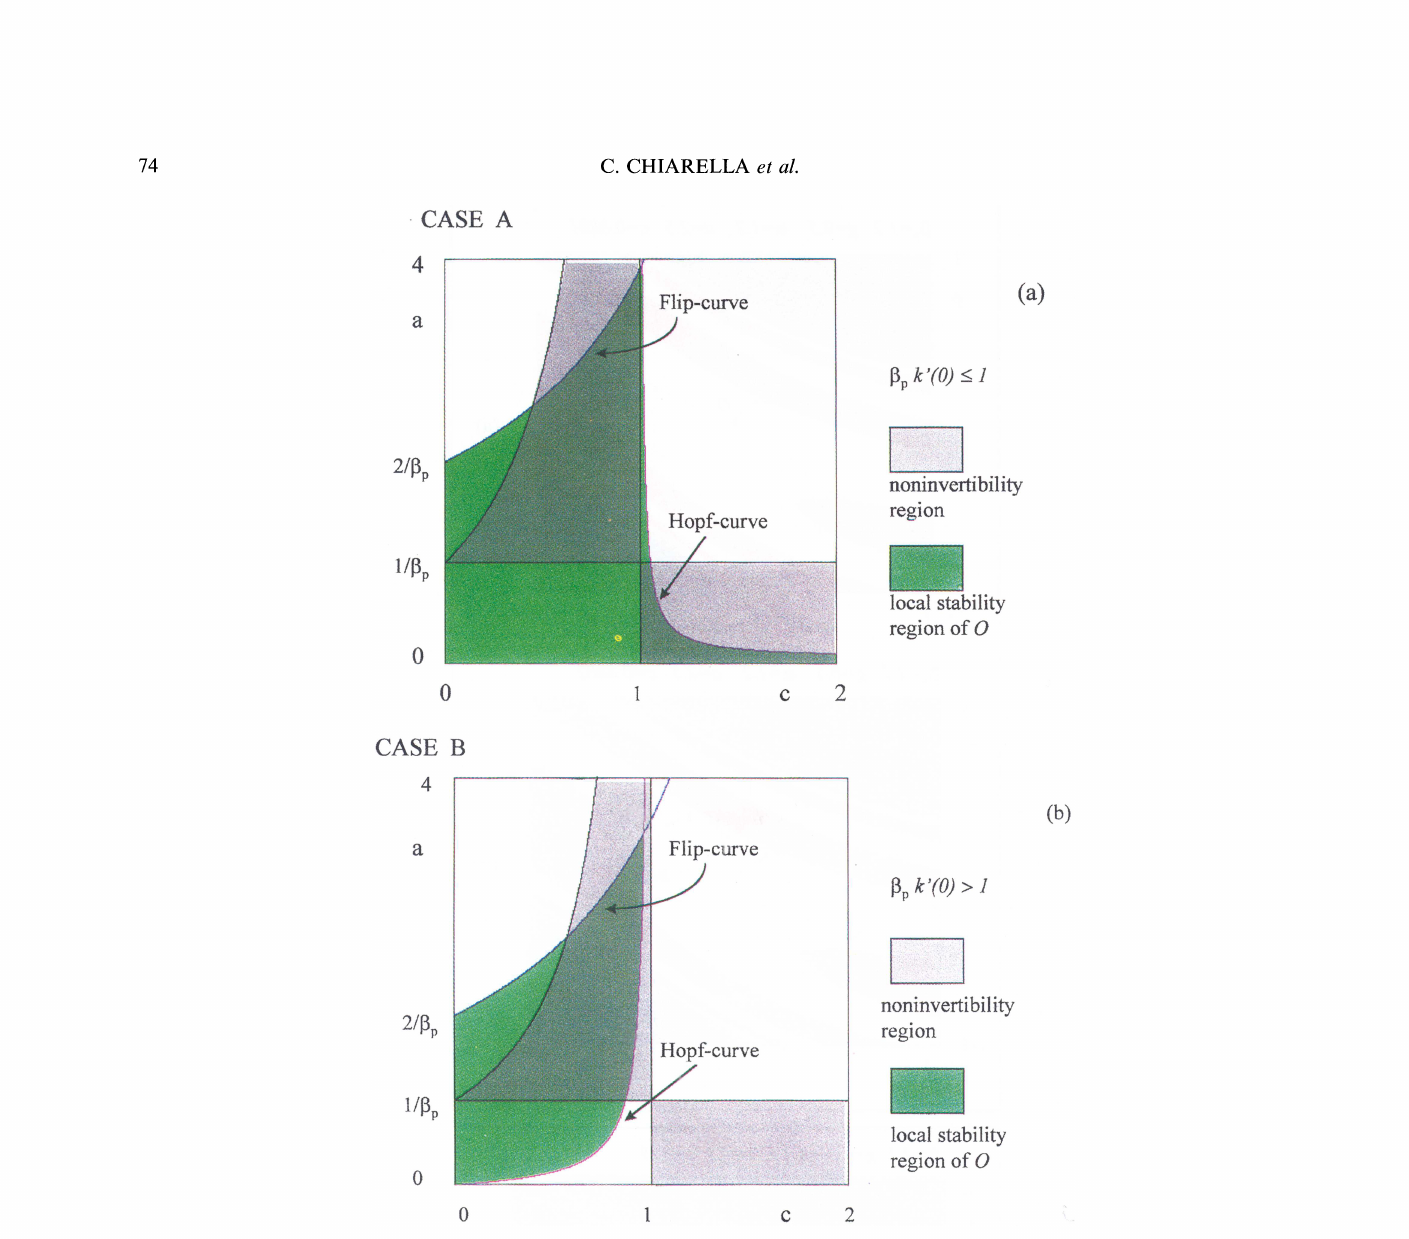
FIGURE The green regions in (a) and (b) represent the stability regions ofthe equilibrium point O in the plane of the parameters c (speed of adjustment of chartists’ expectations) and a (strength of fundamentalists’ demand), while the grey regions represent the domain of noninvertibility of the map T in the same (c, a) parameter plane. Figure (a) is obtained with values of the parameters c,g such that 13pk’(O) pC/(1 + g2) <_ 1. In this case (case A) the domain of stability includes any value c (0, 1) for sufficiently low values of a and the stability can be lost only via a Flip bifurcation as a is increased. Figure (b) describes the opposite case (case B, pU(O) > 1), where stability can be lost also via a Neimark-Hopf bifurcation. This figure also shows that for sufficiently low values of a the map is invertible for any value c (0, 1) and comparing (a) and (b) we see that the stability region is wider in case A than in case B. (See Color Plate